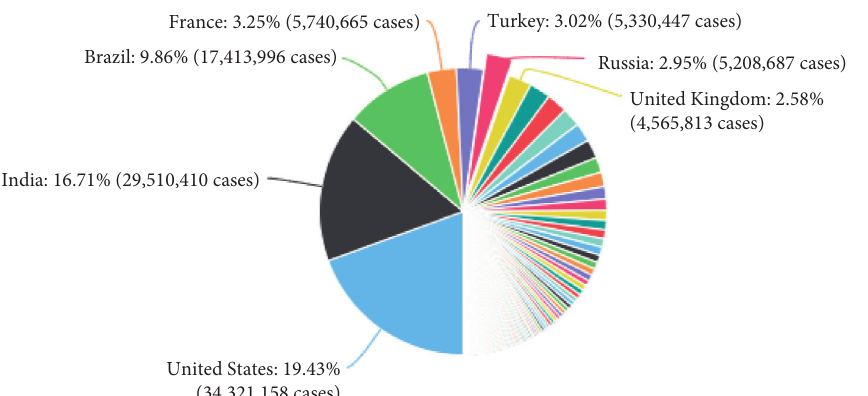
Figure 1: Distribution of cases all over the world. Source: Worldometer